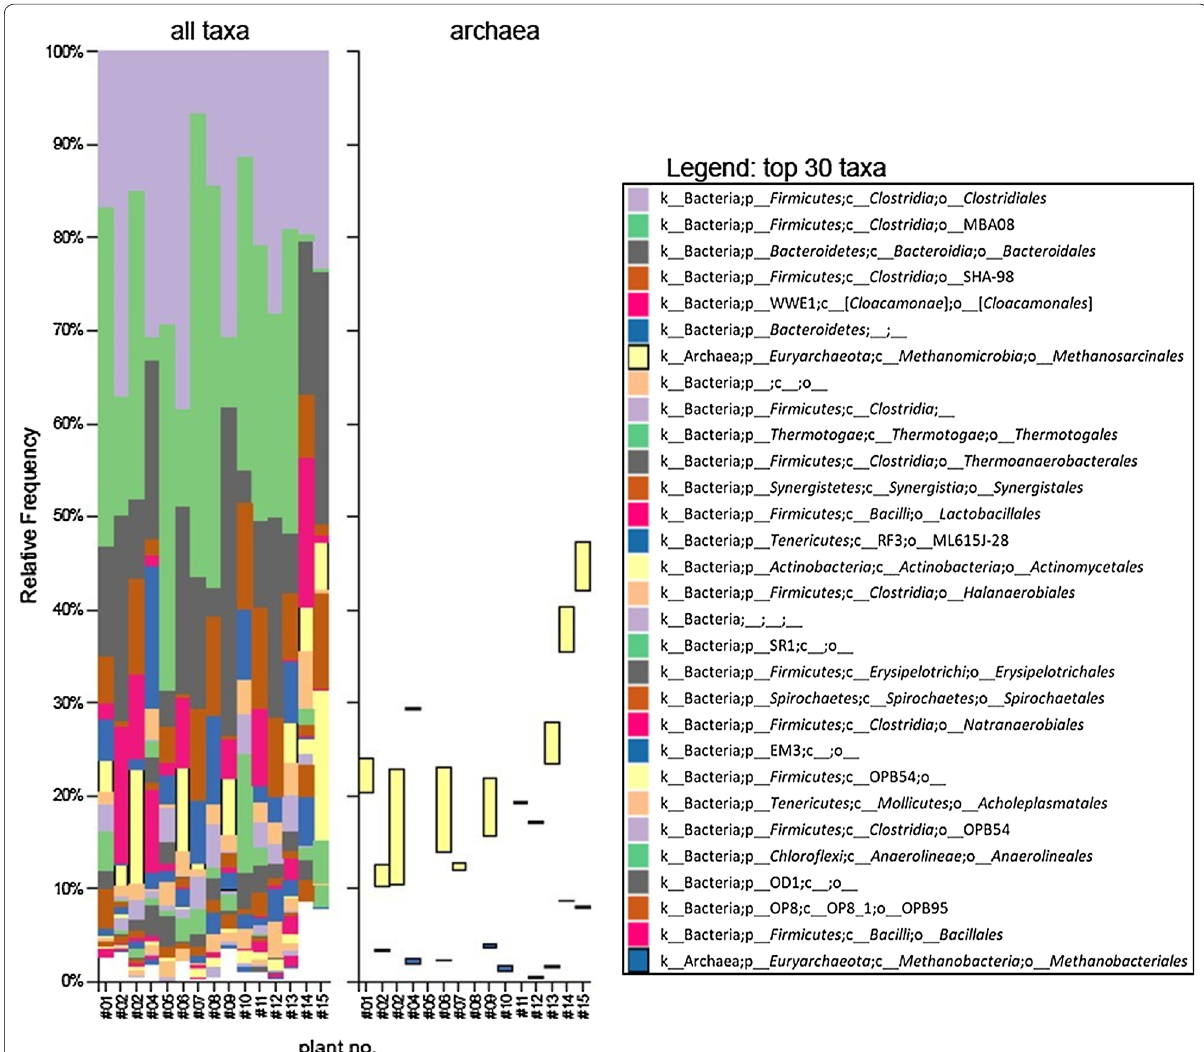
Fig. 1 Taxonomic classification of the 16S amplicon reads obtained from metagenomic DNA of biogas plants and sewage sludge digestors. The relative frequency (in decreasing amounts) of taxonomic groups at the level of “order” is shown for all taxa at the left, and for archaea at the right. Only the most abundant 30 taxonomic groups averaged over all samples are shown; the full dataset is available as Additional file 2. x‑axis: plant number as assigned in Table 1; y‑axis: relative frequency of taxonomic